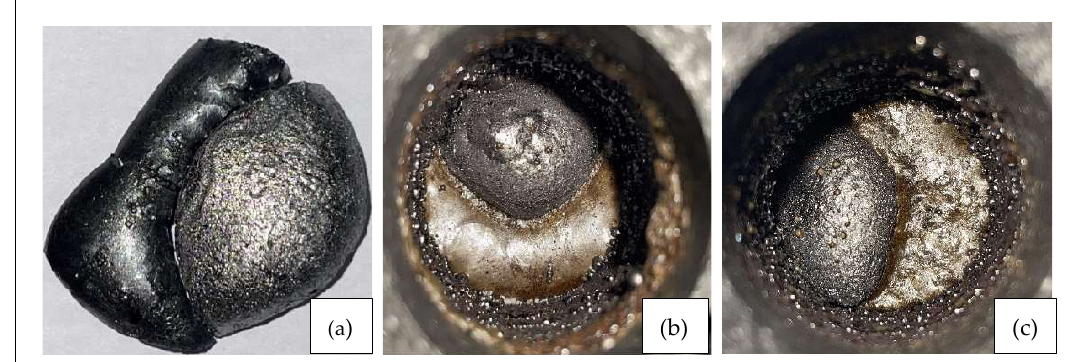
Figure 6. Post experimental observations: Metal Slag separation in V1 ( a ), V2 ( b ), V3 ( c ) . The chemical composition of the metal phase from the NdFeB sample is shown in Figures 7 and 8, and the main component is iron for both samples, with traces of several other elements, such as the REEs and boron. Comparing the initial concentrations of the pre-oxidized materials with 73.8 wt.% Fe in NdFeB, the increase in Fe content confirms that the methodology of using carbothermic reduction with clay graphite crucible as the source of carbon supply is viable.